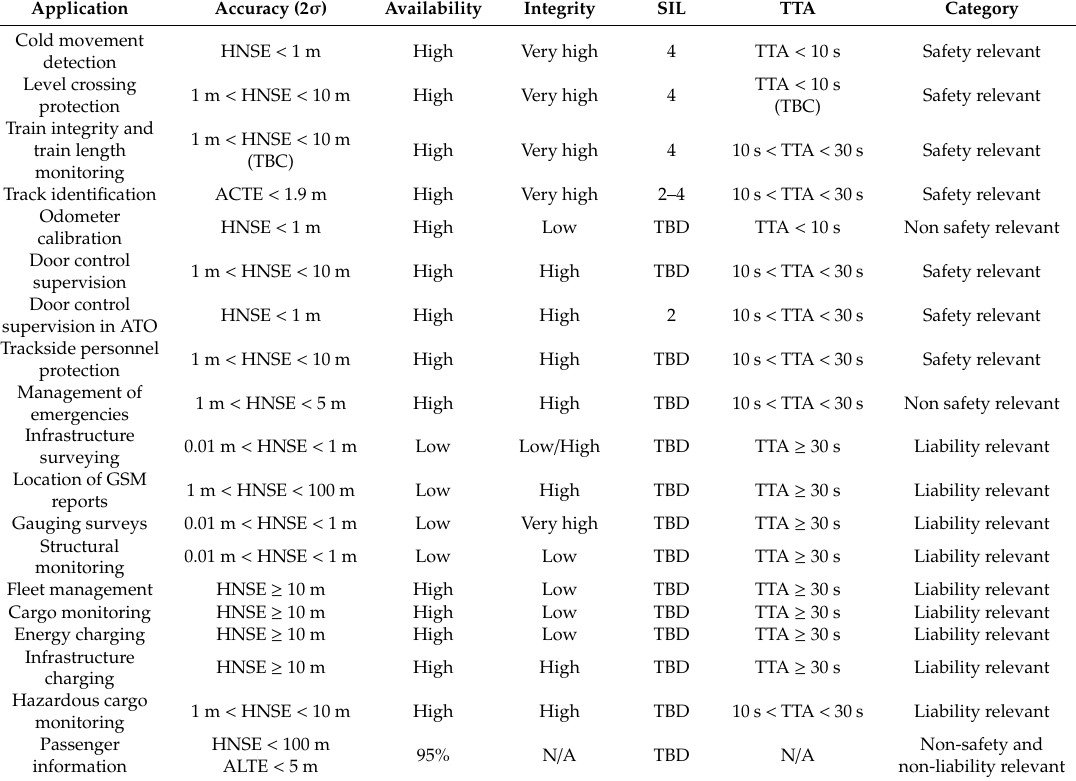
Table 2. Navigation requirements for railway applications. Own study based on: